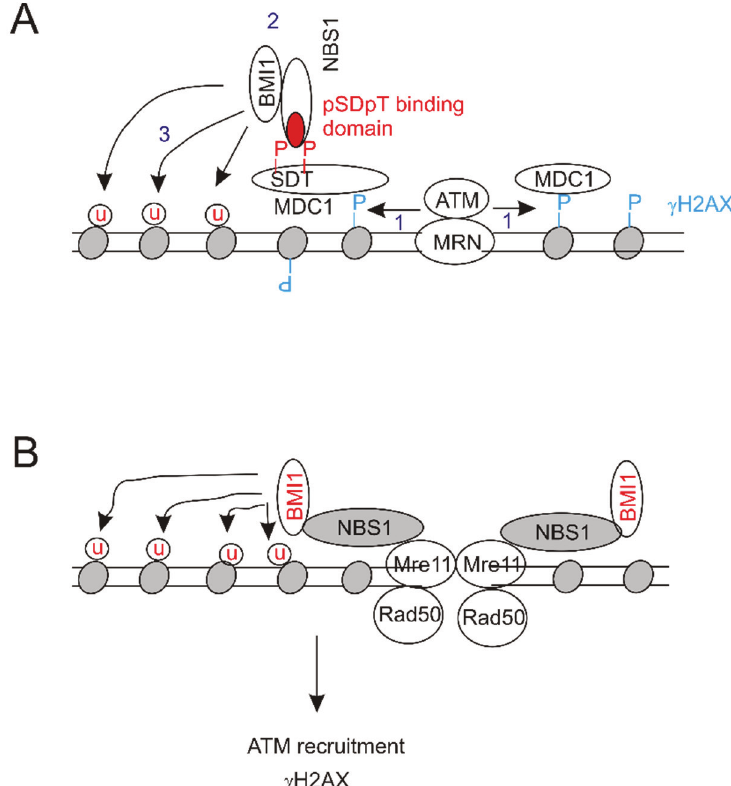
Figure 2. Potential pathways underlying the ubiquitination of H2A/H2AX by the BMI1-associated E3 ubiquitin ligase. ( A ) ATM (ataxia-telangiectasia mutated) is